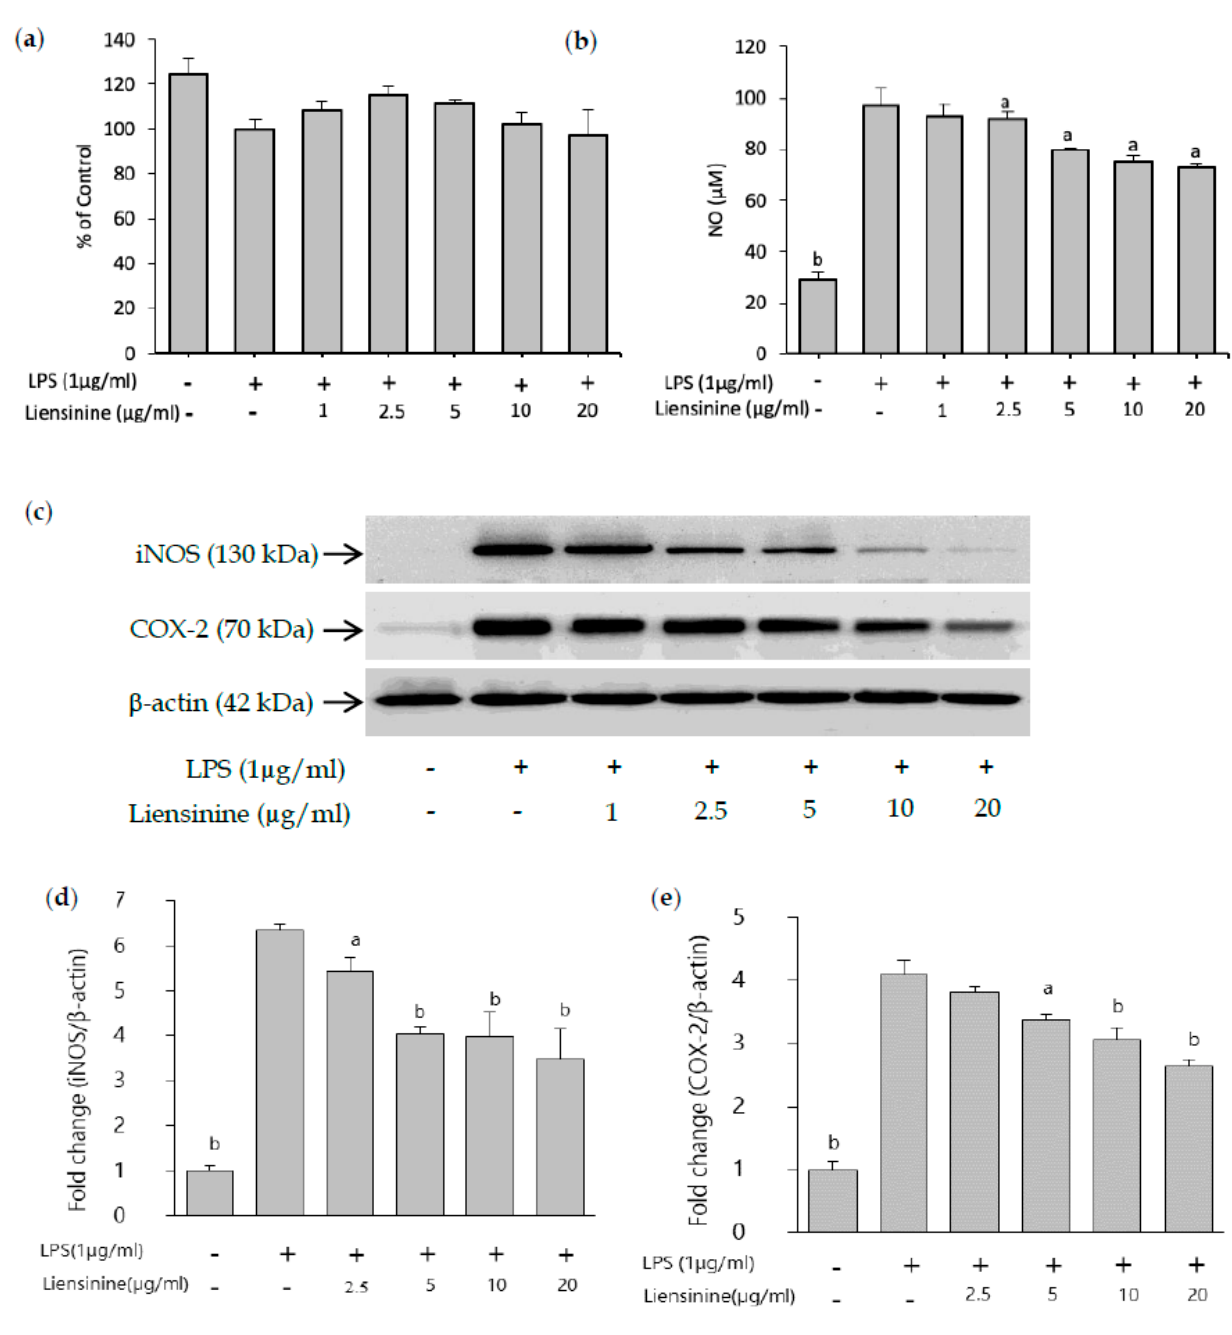
Figure 6. The effects of liensinine on cell viability, nitric oxide (NO) release, and protein expression of iNOS and COX-2. ( a ) Cytotoxicity/cell viability was done by MTT colorimetric assay. ( b ) The effect of liensinine on NO release was determined by Griess reagent assay. ( c ) The expression of the inflammatory proteins iNOS and COX-2 was done by immunoblot. 𝛽 -actin was used as housekeeping/reference control to calculate relative fold change. ( d ) The fold change of iNOS. ( e ) The fold change of COX-2. a p < 0.05 and b p < 0.01 vs. Control (only LPS). n = 3 replicates.